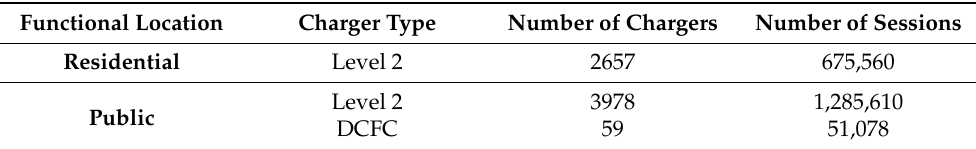
Table 1. Overview of Charging Session Data by Location and Type of